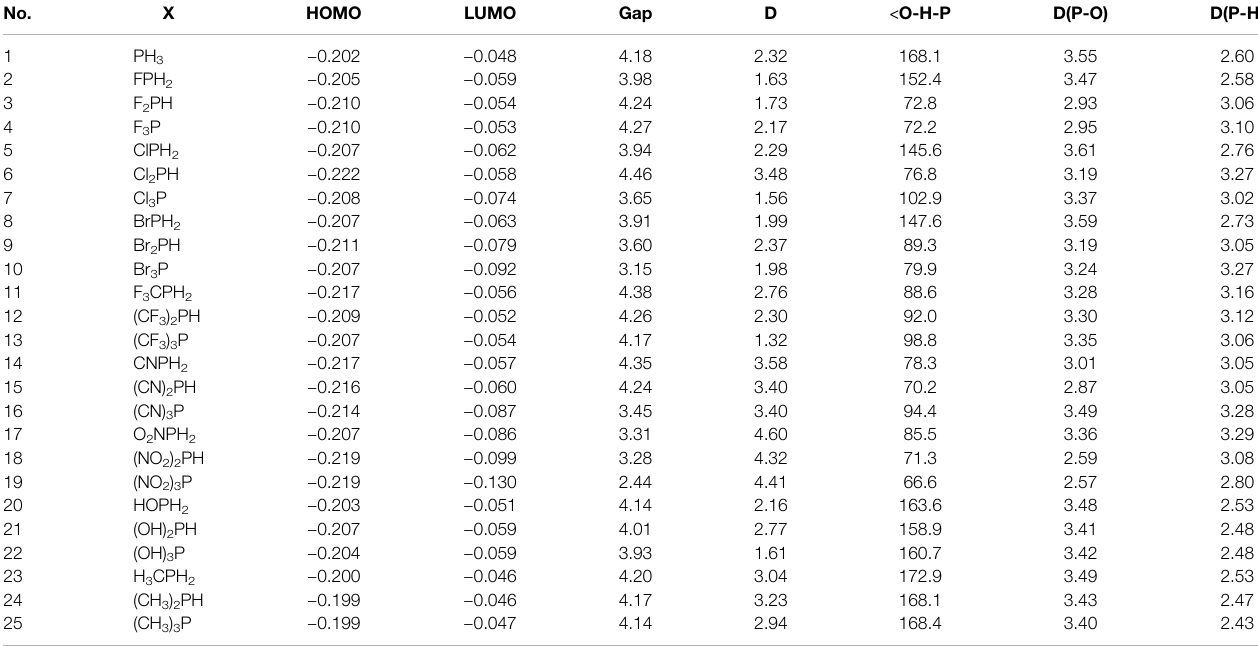
TABLE 5 | Orbital energies of the HOMO and LUMO (hartree), band gap (eV), and dipole moment (D) for the X-epi-CD1 complexes.